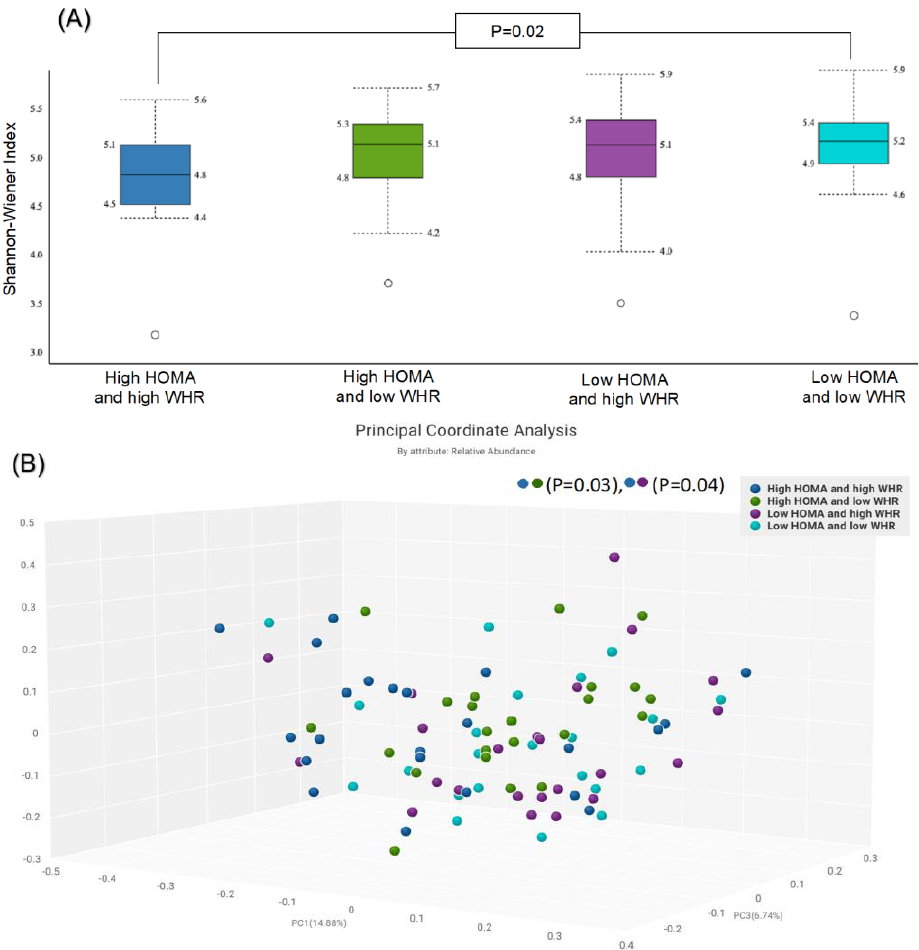
Figure 3. Comparison of bacterial diversities between the gut microbiota of the groups with high HOMA and high WHR, high HOMA and low WHR, low HOMA and high WHR, and low HOMA and low WHR: ( A ) α -diversity, ( B ) β -diversity.